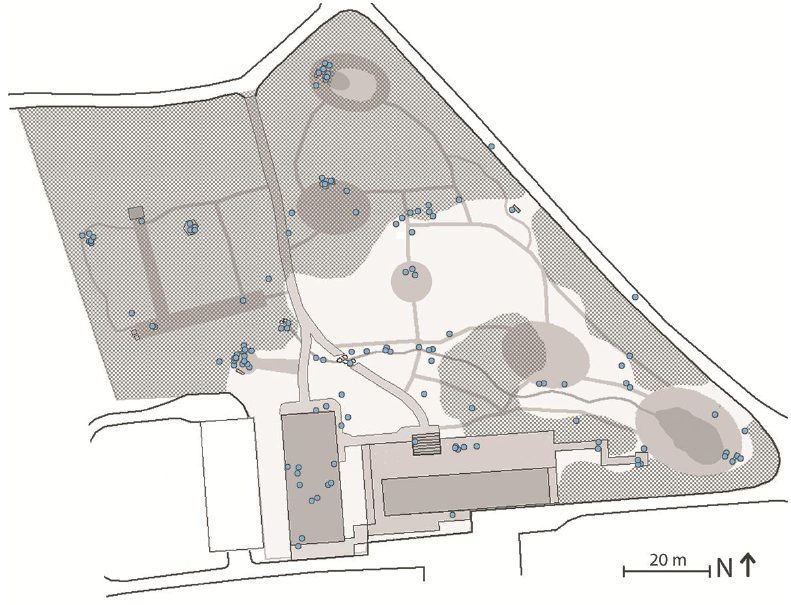
Figure 10. Distribution of ‘own time’ operations as observed from August 2013 to March 2015.